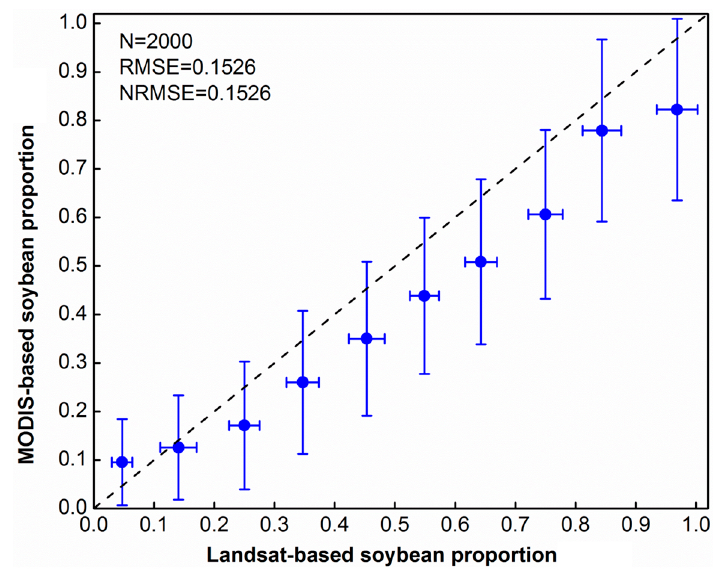
Figure 9. MODIS versus Landsat sub-pixel soybean fractions in Heilongjiang based on 2000 validation samples. Results are summarized for each 0.1 bin (0–0.1, 0.1-0.2, 0.2-0.3, 0.3-0.4, 0.4-0.5, 0.5-0.6, 0.6-0.7, 0.7-0.8, 0.8-0.9, 0.9-1 increase). The dots indicate median soybean proportion at each bin. The bars correspond to the standard deviation of sub-pixel soybean fractions derived from Landsat (horizontal direction) and MODIS (vertical direction), which can reflect the regression bias.